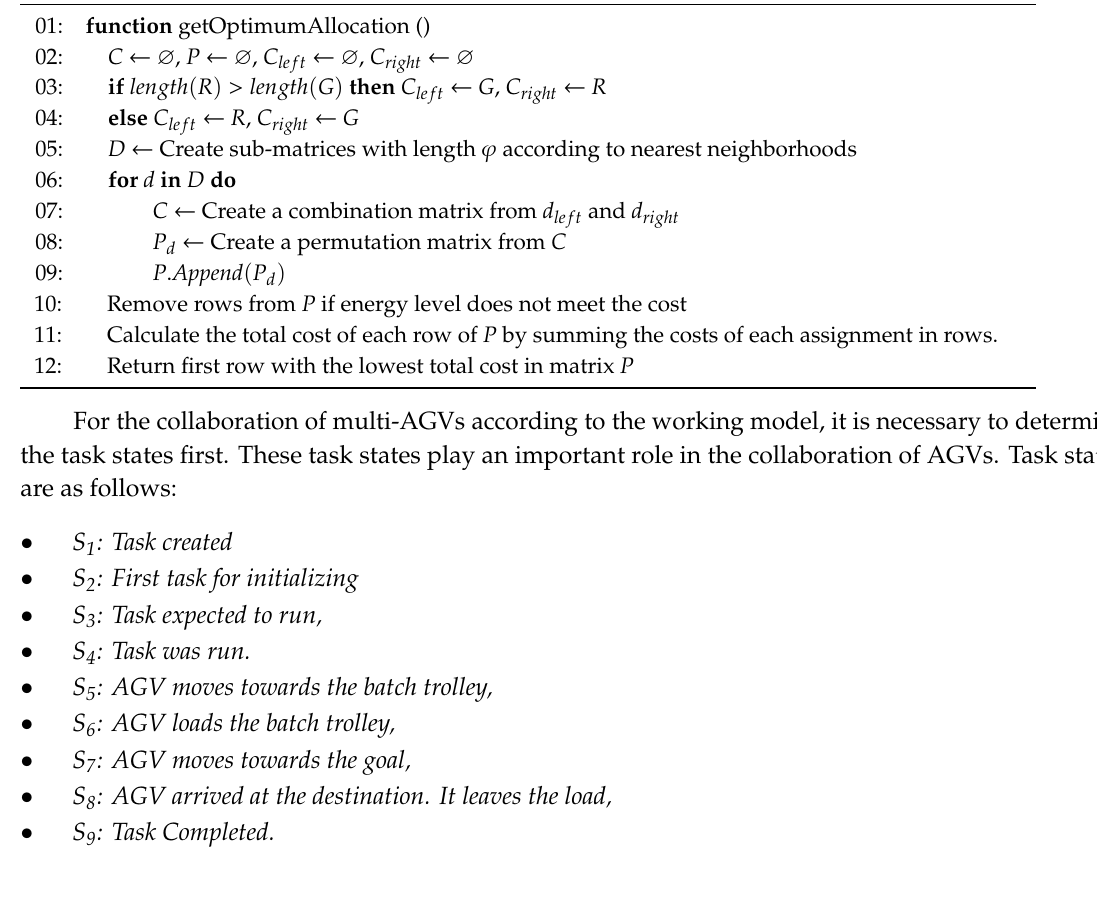
Algorithm 2 Optimum Multi-Task Allocation